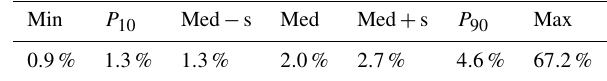
Table 3. Relative error ( (cid:15) rel ) statistics (%): percentiles 10th and 90th ( P xx ), median (med), minimum (min), maximum (max) and disper- sion (s). The dispersion has been estimated robustly by means of 1 . 4826 × MAD, where MAD is the median absolute deviation and 1 . 4826 is the scale factor between MAD and the standard deviation for perfect Gaussian distributions.